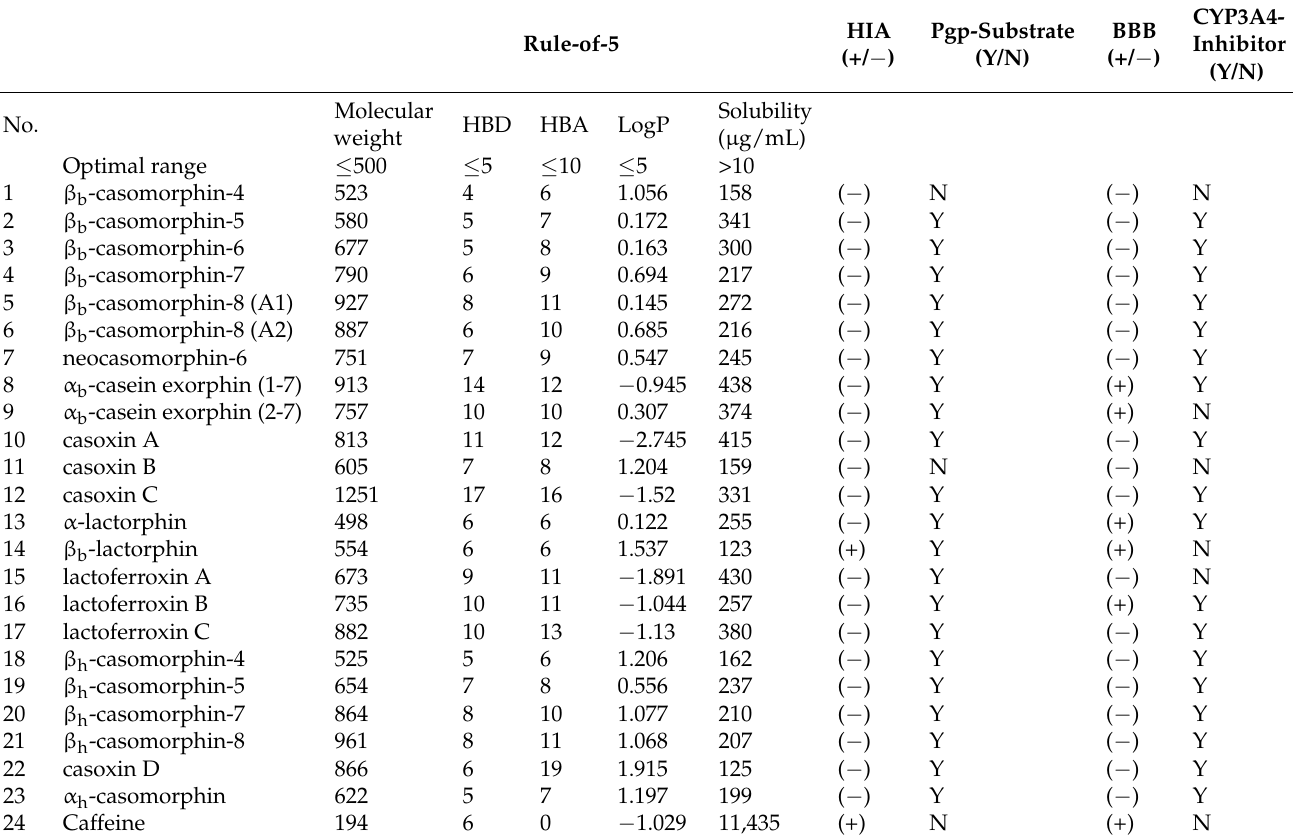
Table 2. In silico drug-likeness, absorption, distribution, metabolism, and excretion profile of the opioid peptides from bovine and human